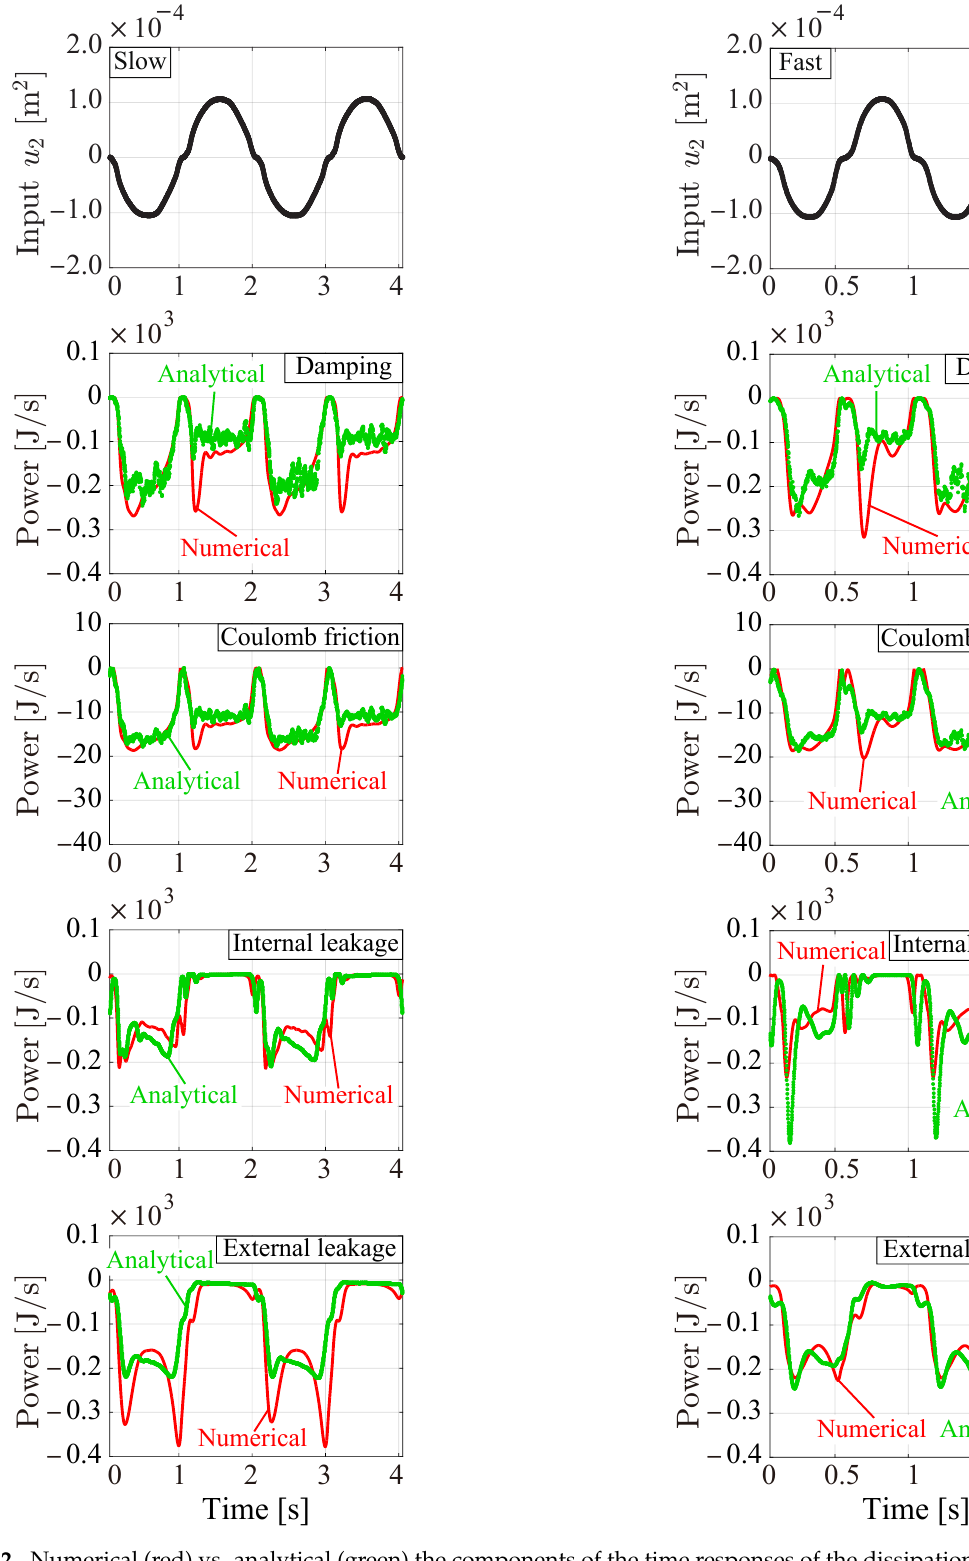
Figure 12. Numerical (red) vs. analytical (green) the components of the time responses of the dissipation term. (Energy behavior analysis, slow: f = 0.5 [Hz], fast: f = 1.0